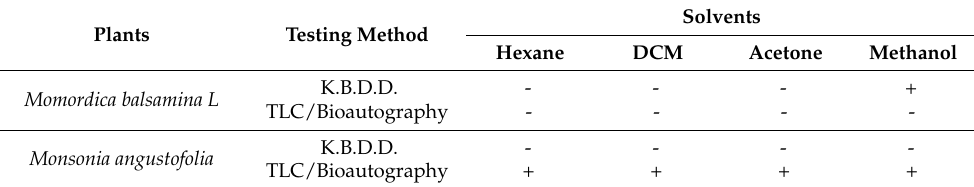
R f values of antibacterial compounds are presented in Table 2. The methanolic M. balsamina Linn extract demonstrated a MIC of 0.5 mg/mL (Figure 3). Table 1. Antibacterial activities of plant extract against A. baumannii .